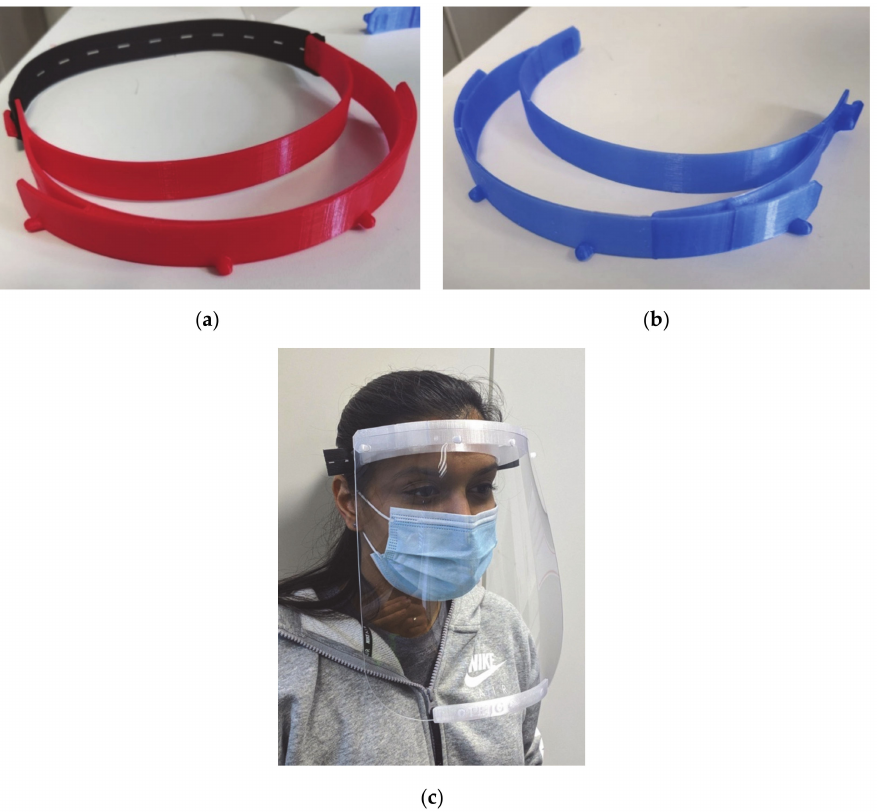
Figure 3. Headband designs for protective face shields; ( a ) simplified design for faster printing, ( b ) Prusa design, ( c ) final face shield in use.